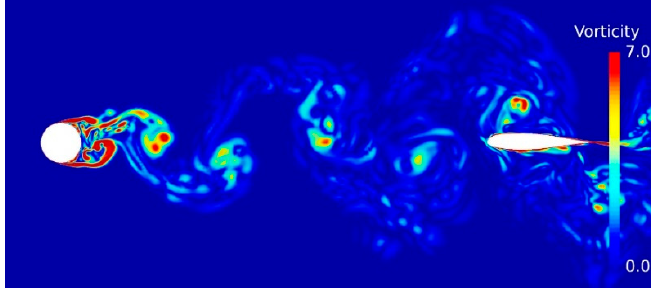
Figure 18. Instantaneous snapshot of normalized spanwise vorticity magnitude (cid:101) ω z = ω z / ( U ∞ D ) from cylinder to airfoil.